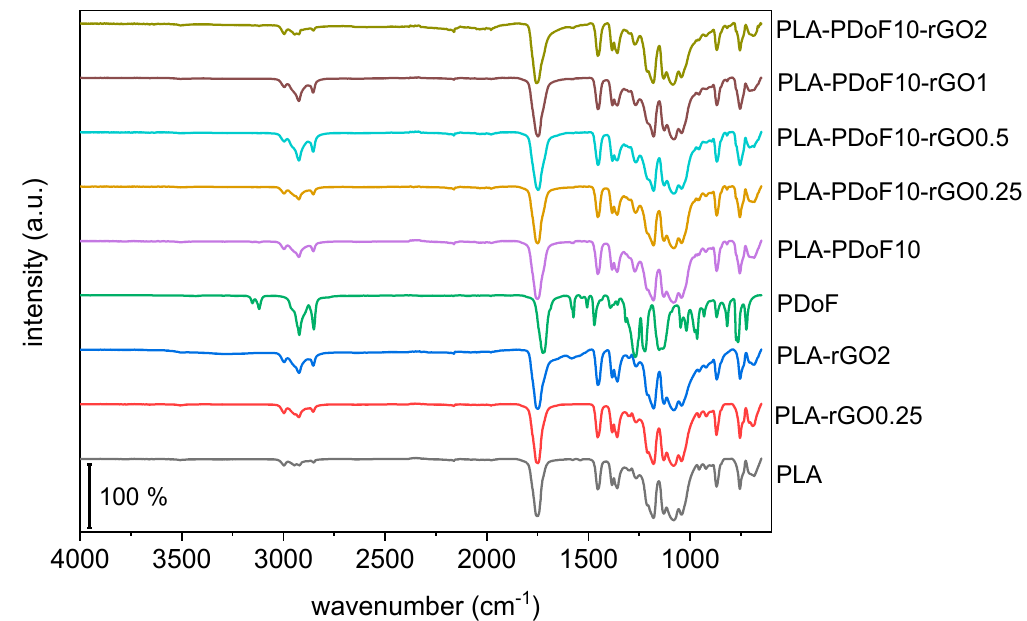
Figure 4. ATR-FTIR spectra of the prepared films. Spectra have been vertically translated and normalized to the most intense peak.